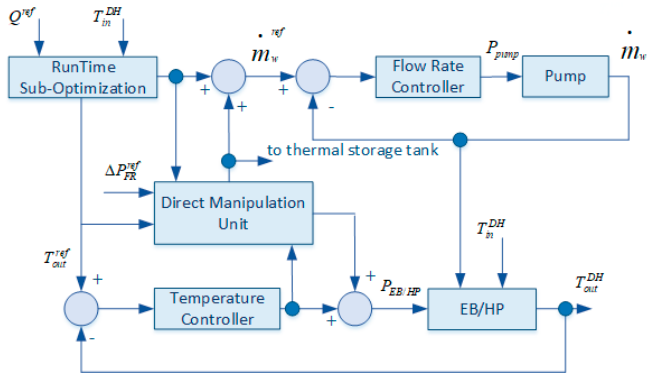
Figure 11. Local control structure for power-to-heat (P2H) units.